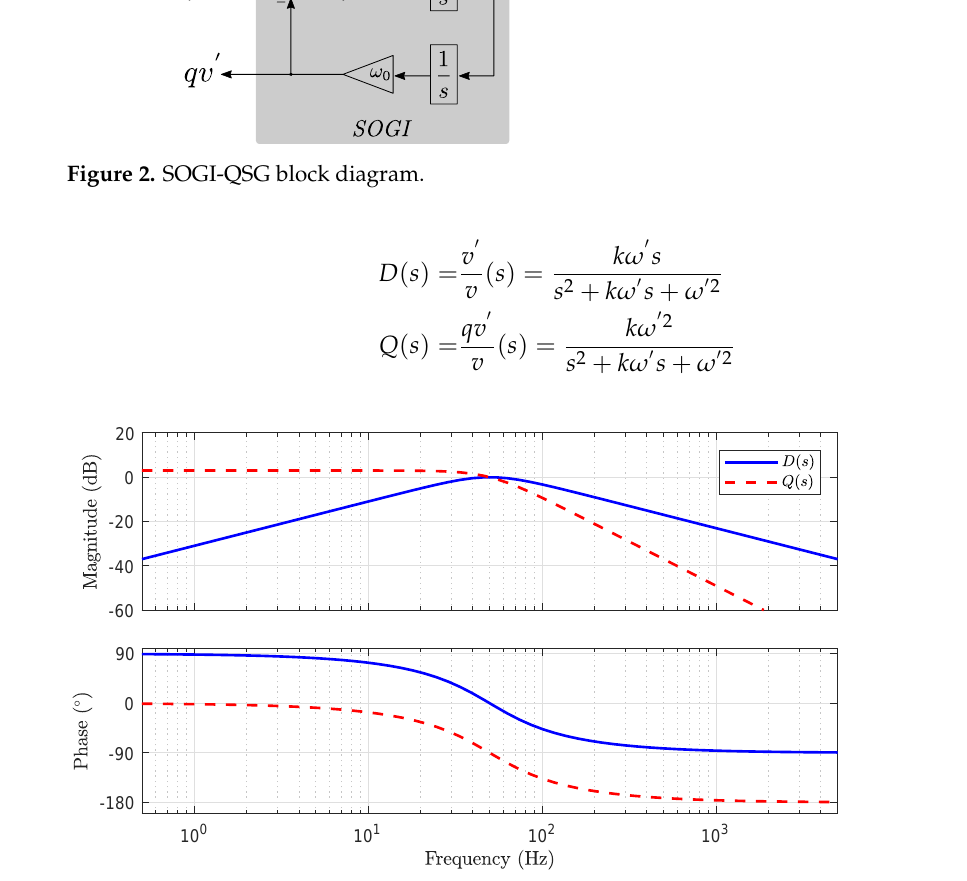
Figure 3. SOGI-QSG bode plot for a centre frequency of 50 Hz and a quality factor k =